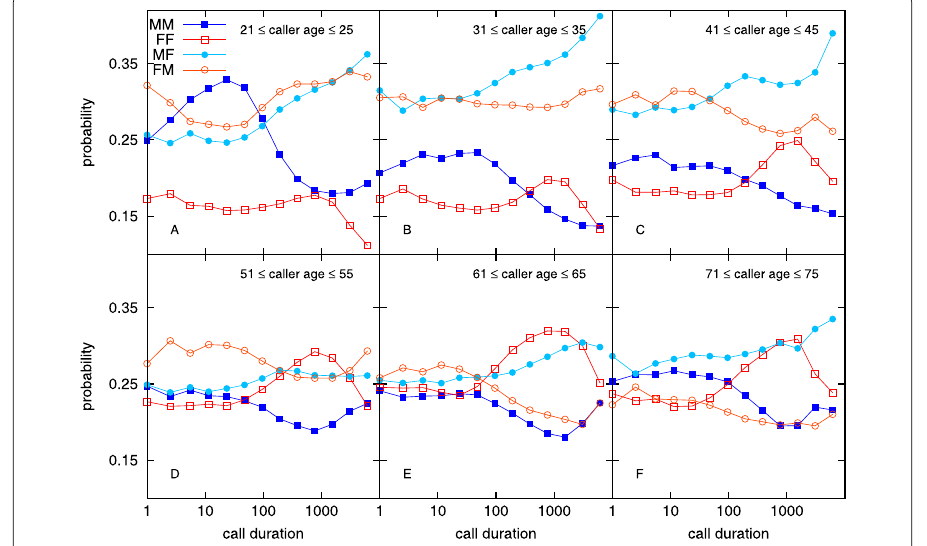
Figure 2 Relative probabilities ( f FF ( g , t ), f FM ( g , t ), f MF ( g , t ), and f MM ( g , t )) of the four possible ways of interaction between same or different gender caller–callee pairs as a function of the call duration (in seconds) for six different age groups of callers, presented as panels of ( A ) 21–25, ( B ) 31–35, ( C ) 41–45, ( D ) 51–55, ( E ) 61–65, and ( F ) 71–75 years old. The relative ranking of these four possibilities is dependent on the age of the caller and the duration of